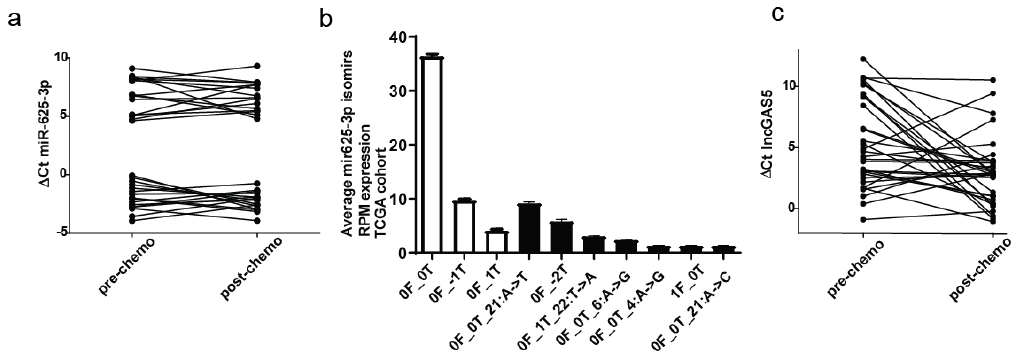
Figure 1. Relative circulating levels of miR-625-3p and GAS5 in plasma samples from 32 malignant